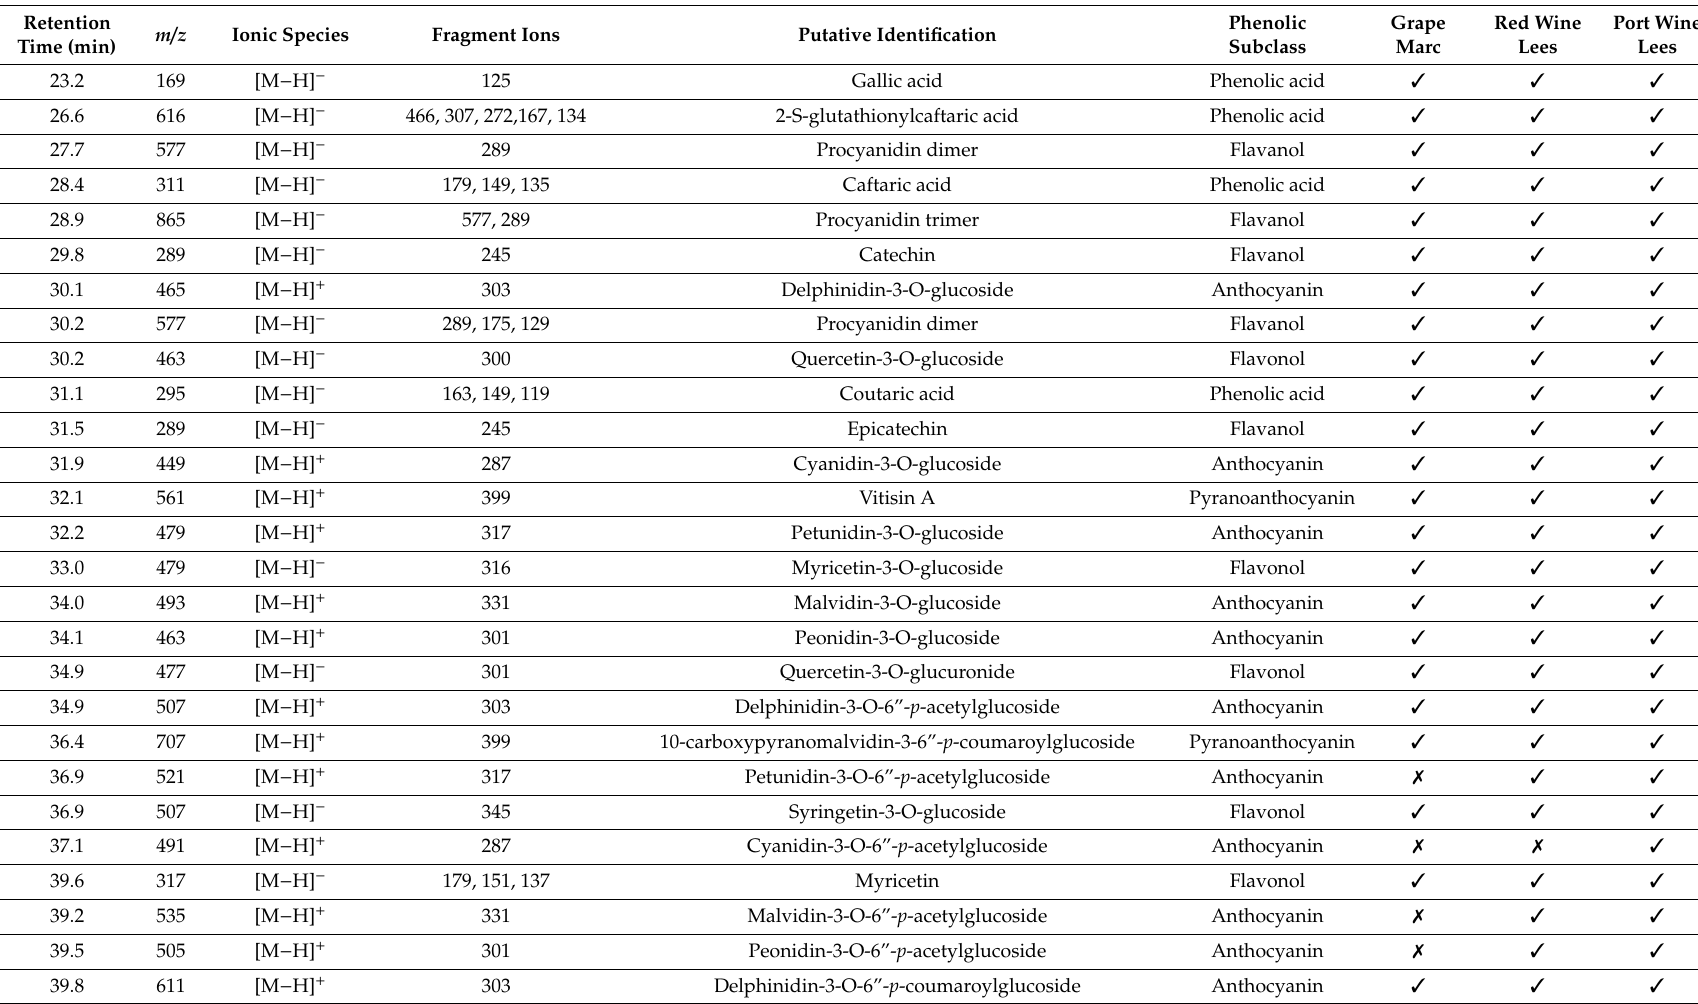
Table 2. The putative identification of phenolic compounds present in grape marc, red wine lees and Port wine lees, as obtained by HPLC-DAD-MS / MS. The retention times, m / z values and respective fragments, as well as the phenolic subclass, are